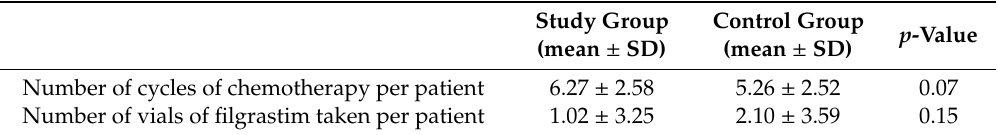
Table 4. Di ff erence between parameters in study and control group.